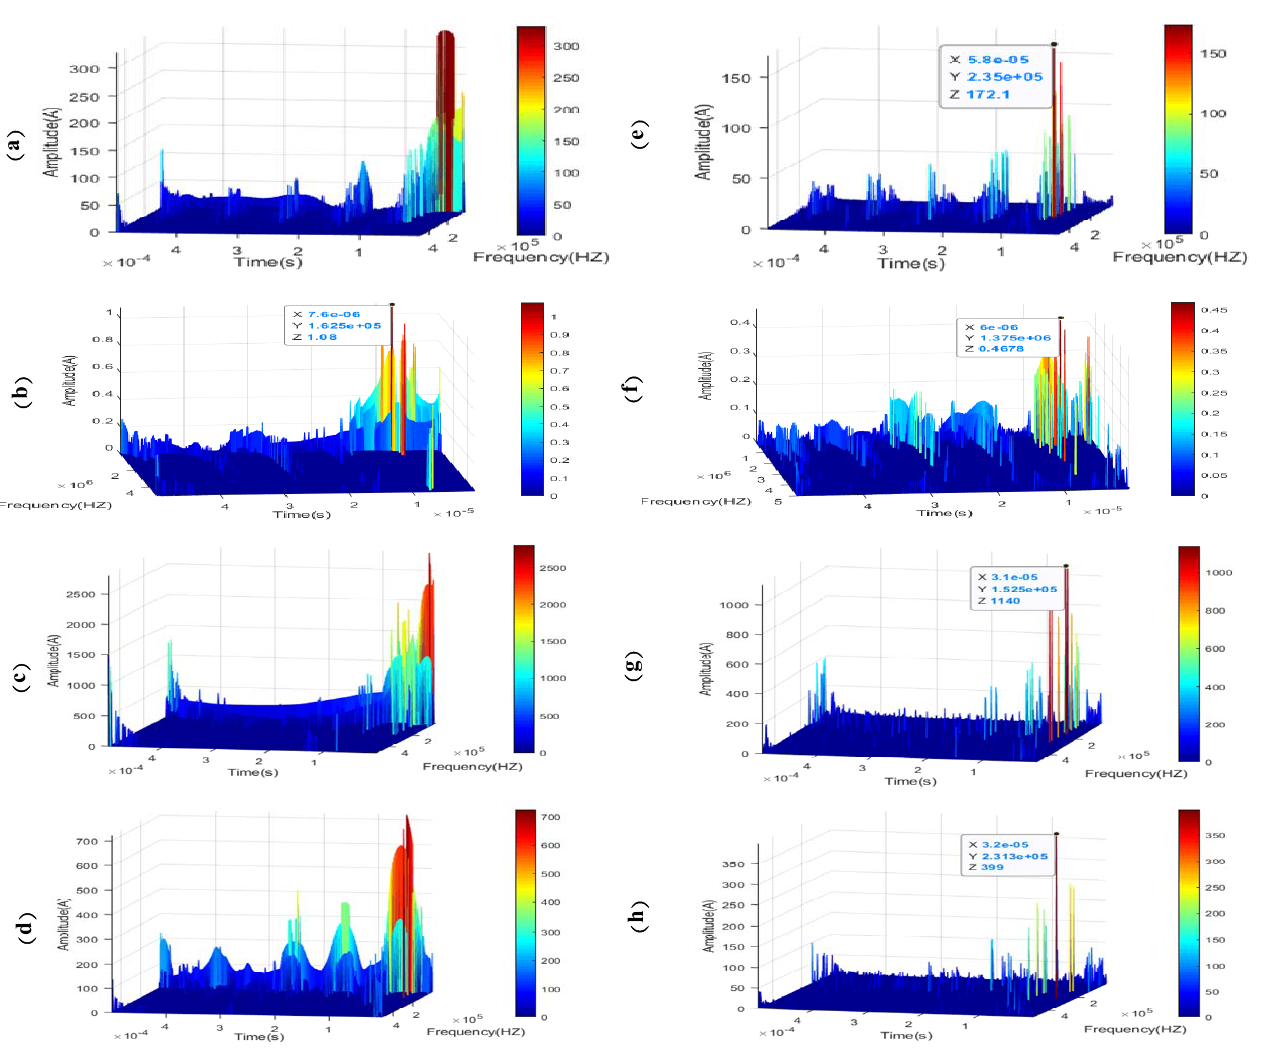
Figure 10. Lightning flashover and non flashover time frequency energy diagram before and after improvement HHT.